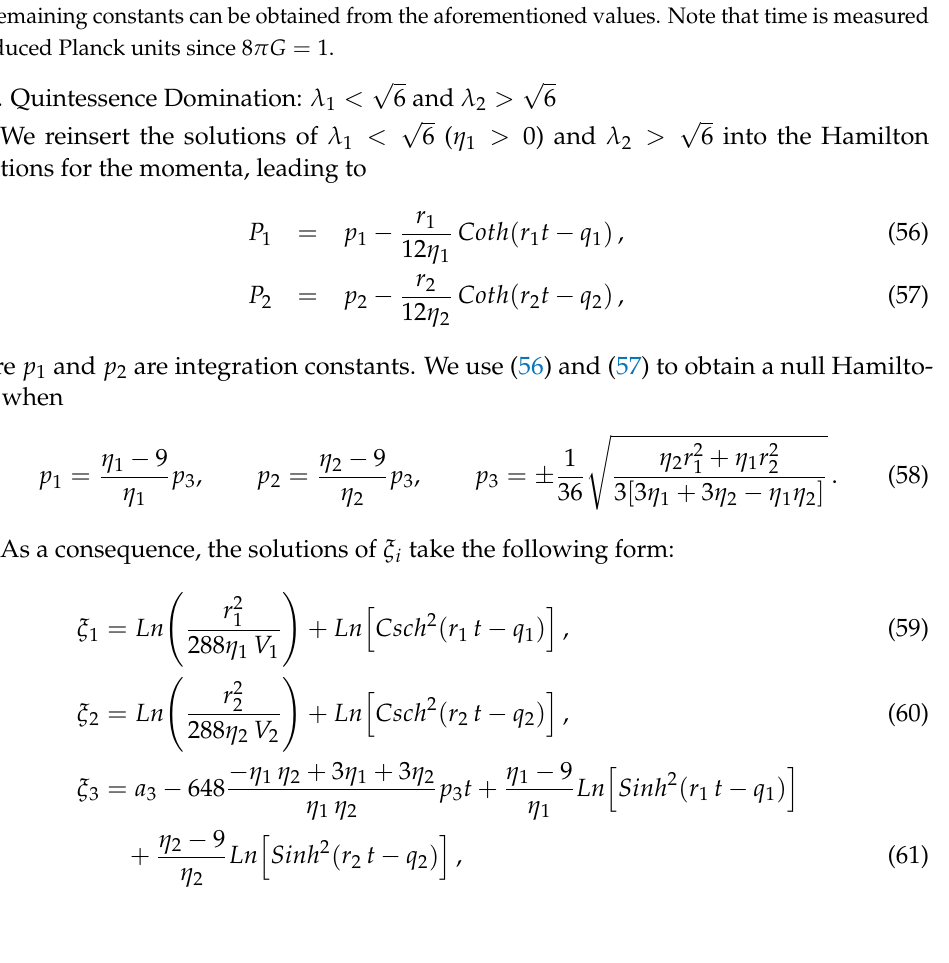
( t ) . We use arbitrary √ 1 φ 2 2, and λ 1 = 6/ λ 2 .